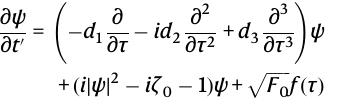
wave. Dashedgraylineinouter fi gures representthe CWhigh-statesolution. Thick bands represent the existence range of structures in the circular path. Further analysis and extended version of this fi gure with a video available in Supplemen- tary